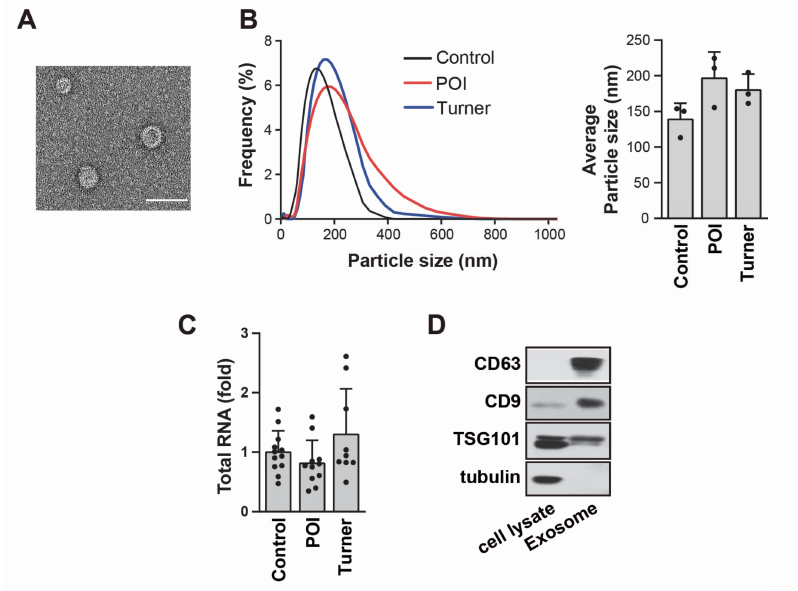
Figure 1. Characterization of exosomes isolated from the urine. ( A ) Phenotype of urinary exosomes detected via transmission electron microscopy. Scale bar: 100 nm. ( B ) Frequency of isolated urinary exosomes revealed via nanoparticle tracking analysis. All average particle sizes were calculated by using three independent samples. ( C ) The amount of total RNA from each sample was measured by using Nanodrop 2000 (ThermoFisher Scientific); patients with premature ovarian insufficiency (POI) = 11, patients with Turner syndrome = 9, control individuals = 12. ( D ) Expression levels of CD63, CD9, and TSG101 in urinary exosomes were detected via Western blot analysis. Tubulin was used as a negative control. Table 5. Differentially expressed microRNAs in the sequencing